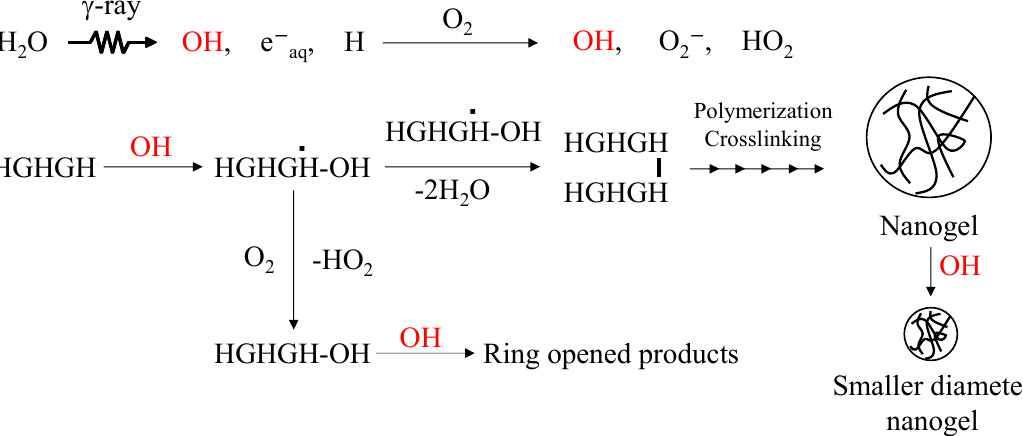
Figure 6. Simulated crosslinking density of ( a ) H5, and ( b ) H9 nanogels as a function of radiation dose.